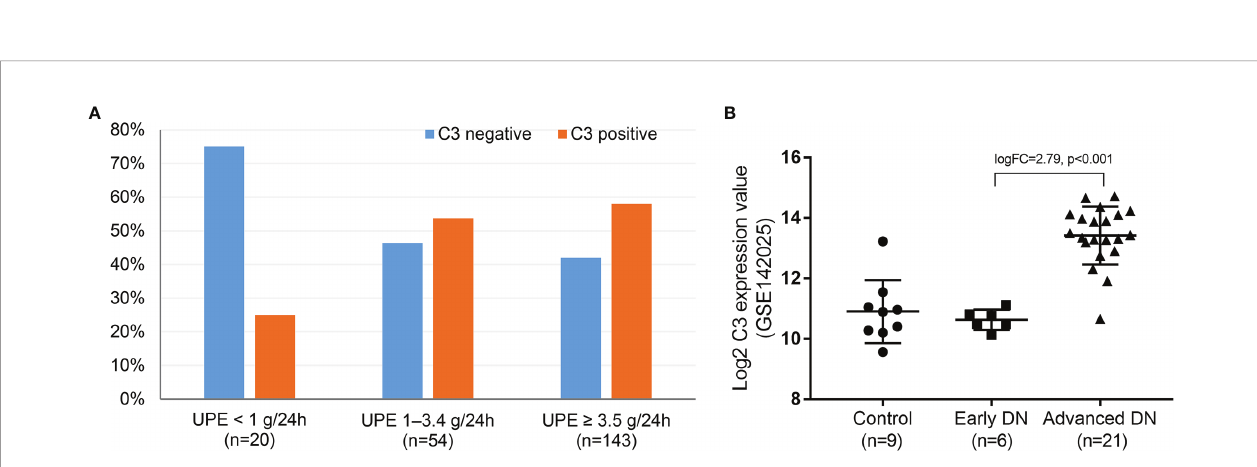
FIGURE 6 | Diabetic nephropathy with Kimmelstiel – Wilson nodule (A) (light microscopy, ×200), and prominent thickening of glomerular basement membranes with expanded mesangium and a small amount of mesangial electron-dense deposits (B – C) (electron microscopy; ×5,000).